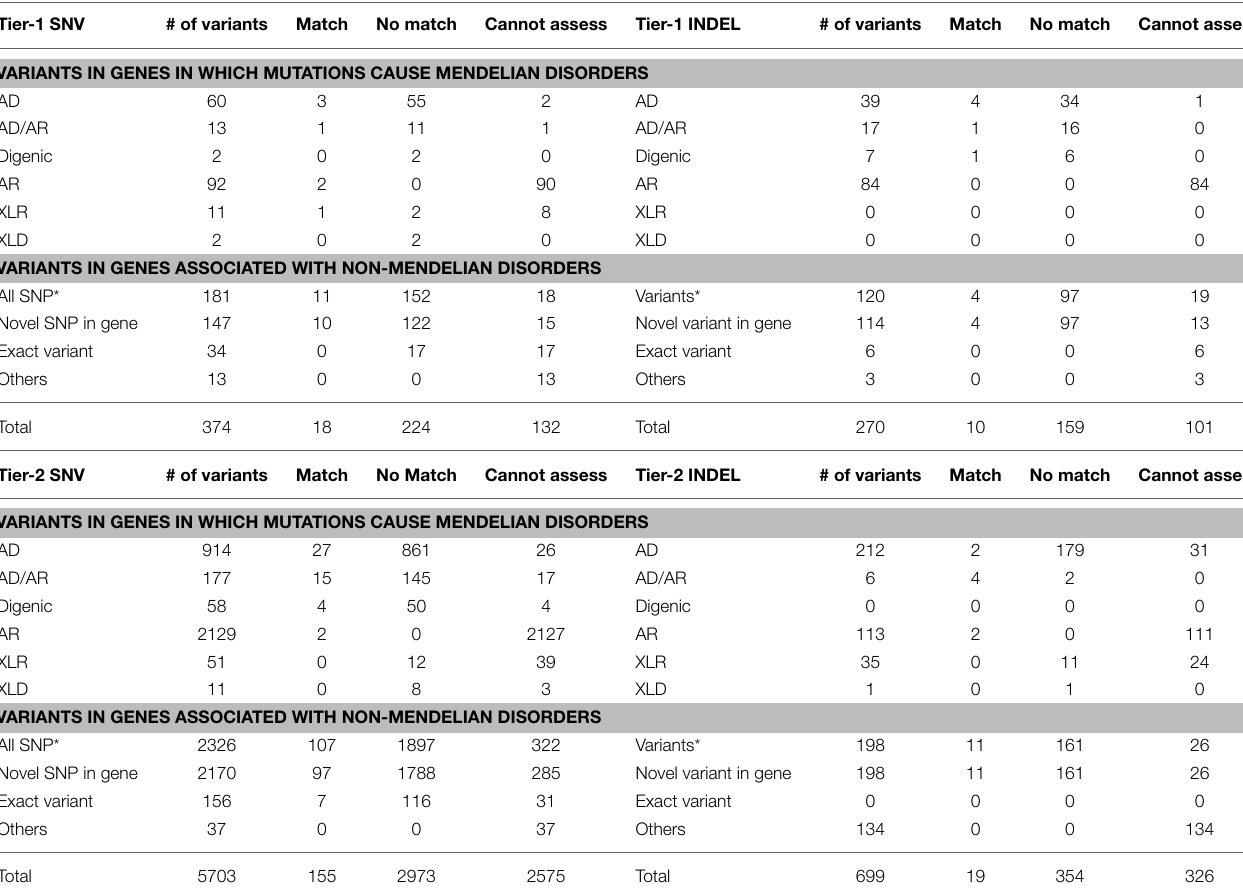
TABLE 2 | Summary of the proportion of variants and their correlation with any known phenotypic findings from the chart